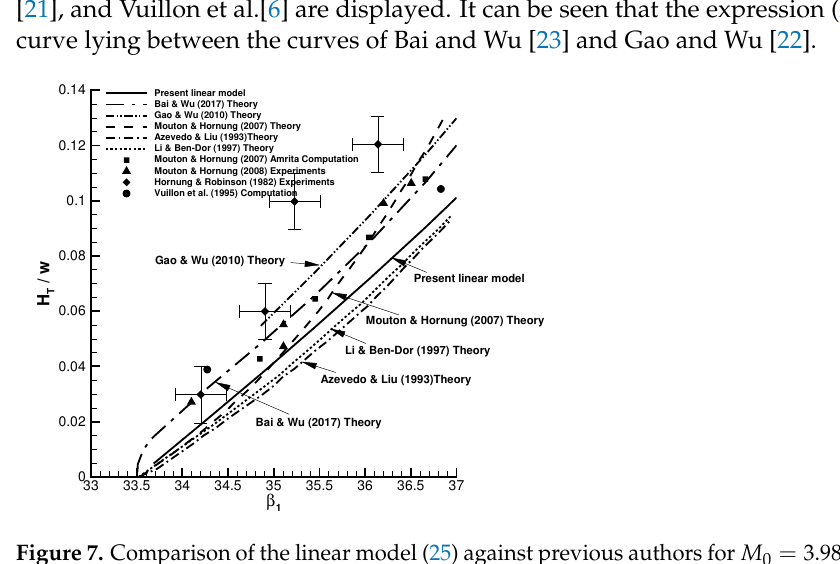
Figure 7. Comparison of the linear model (25) against previous authors for M 0 = 3.98 and g / w = 0.4. The comparison of linear expression (25) with the present numerical solutions (already shown in Figure 3a–c and Figure 5a,b of Section 2) is given in Figure 8a–e. It is seen that, though the expression (25) displays linearity as CFD simulation, the slopes of the linear curves signficantly differ from the CFD results.